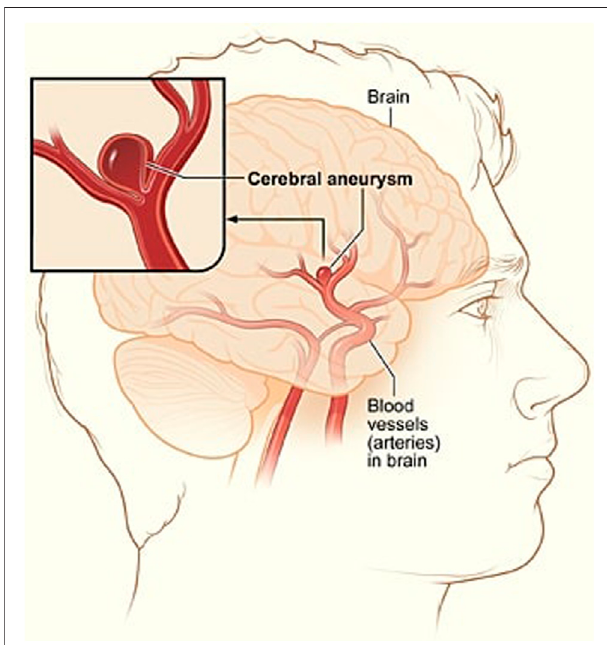
FIGURE 1 | A depiction of cerebral aneurysm adapted from Ref. You et al. (2017).